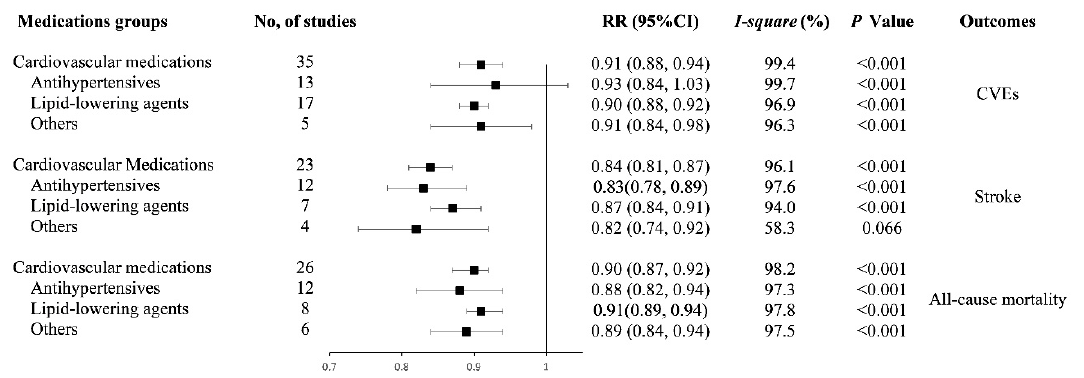
Figure 2. Forest plot of study-specific relative risk statistics for dose-response meta-analysis. Abbreviations: RR: relative risk; CI: confidence interval; CVEs: cardiovascular events; and other medications: multiple and antithrombotic medica- tions.